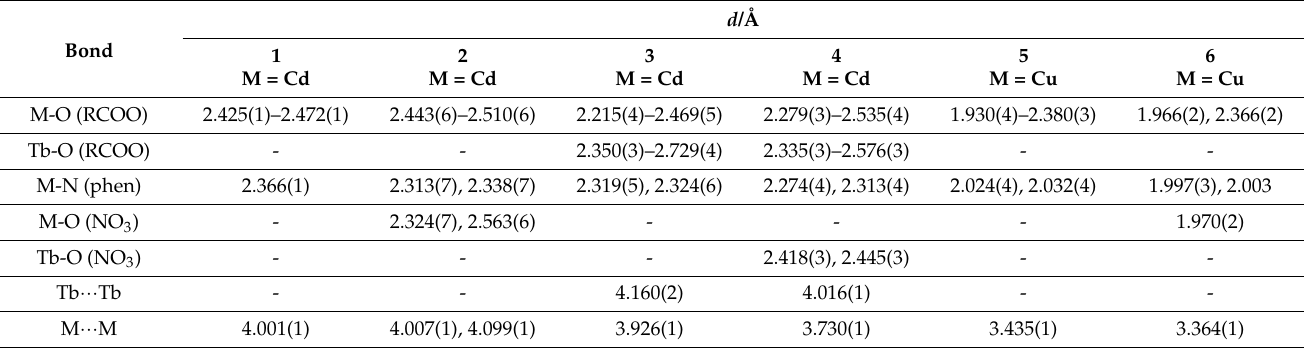
Table 1. Main bond lengths for complexes 1–6 .